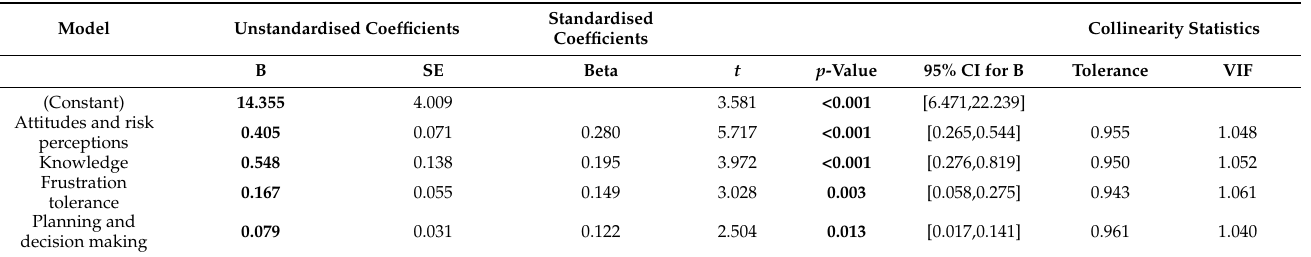
Table 2. Linear regression analysis of the influence of knowledge, attitudes, and risk perceptions of COVID-19, and psychological variables on COVID-19 protective health